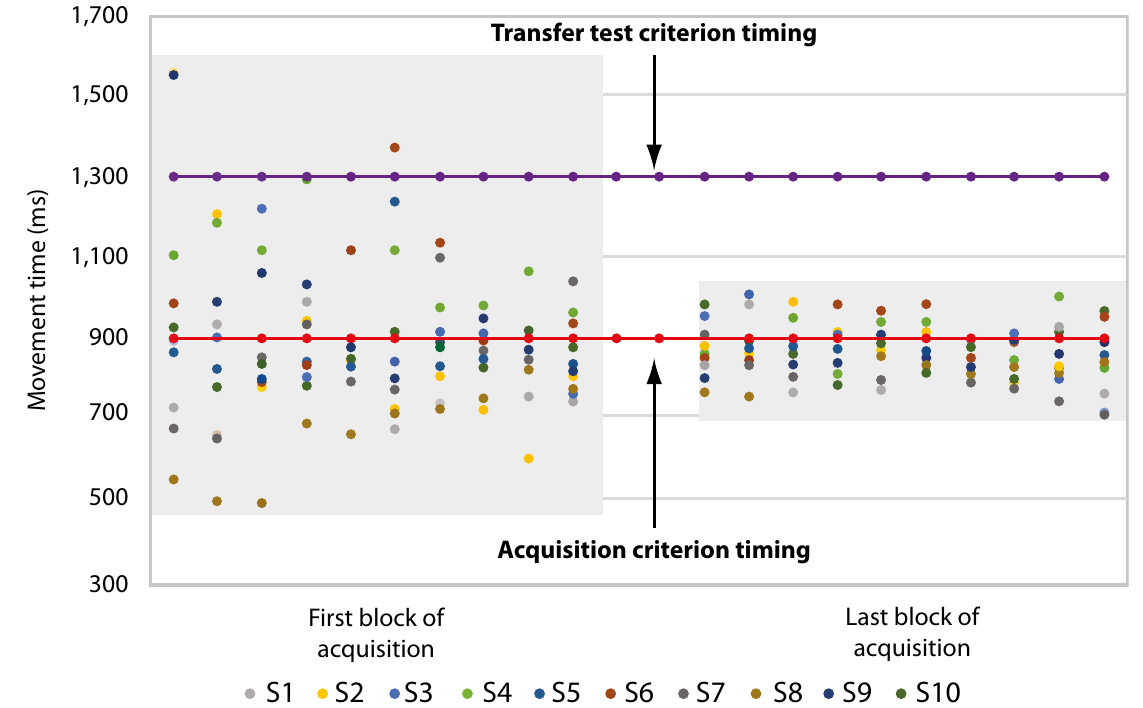
Figure 3. Motor response dispersion in the first and the last block of acquisition during the constant